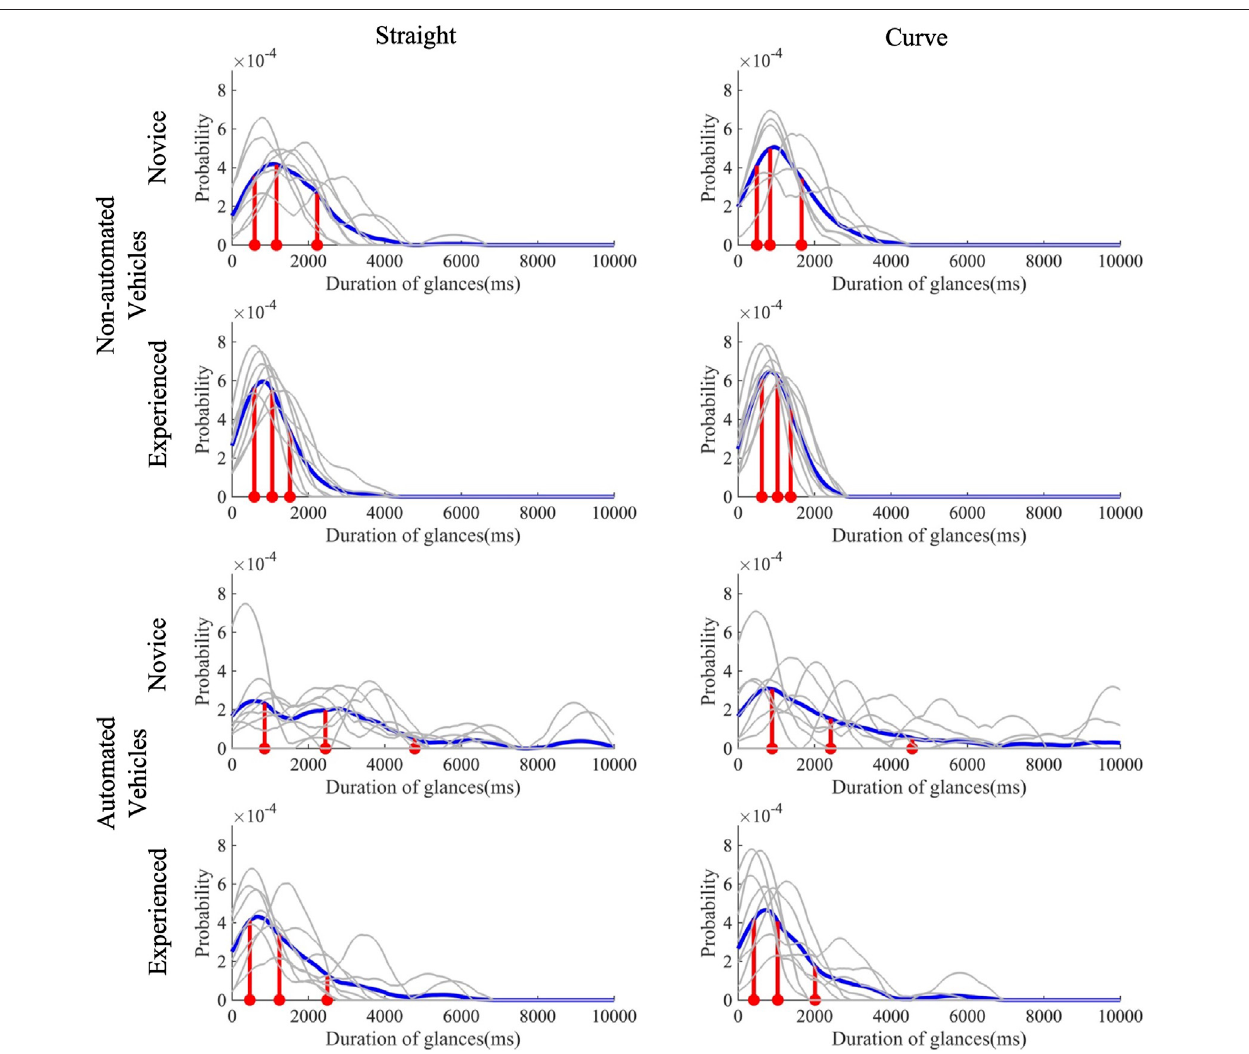
FIGURE 3 | Distribution of glance durations toward the secondary task. The grey lines represent the distribution of glance durations for each participant and the bluelinesrepresentthedistributionofallglancesfromallparticipantswithineachexperimentalcondition.Fromlefttoright,theverticalredlinesmark15thpercentile,50th percentile, and 85th percentile glance durations extracted from the quantile regression